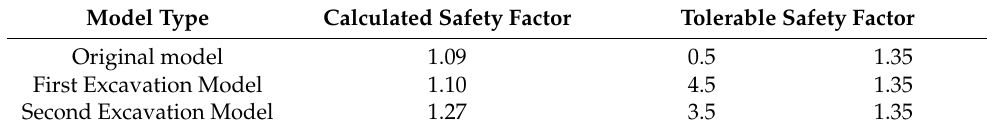
Table 2. Strength parameters of slope